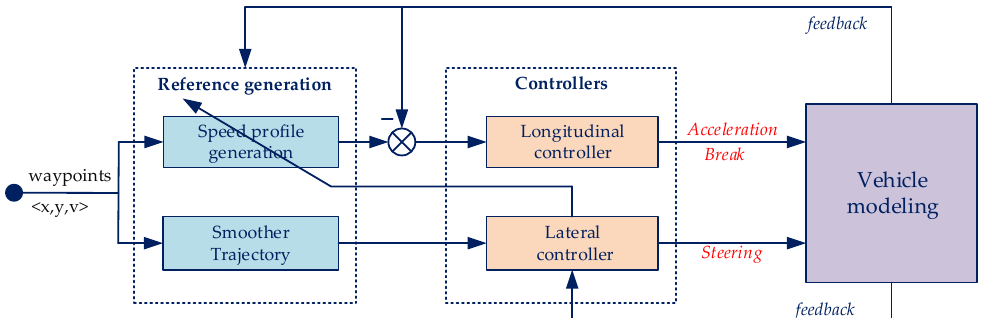
Figure 6. The control system architecture consists of longitudinal control with the Scheduled Feedforward PI (SFF-PI) controller and lateral control using the adaptive-Pure Pursuit Controller